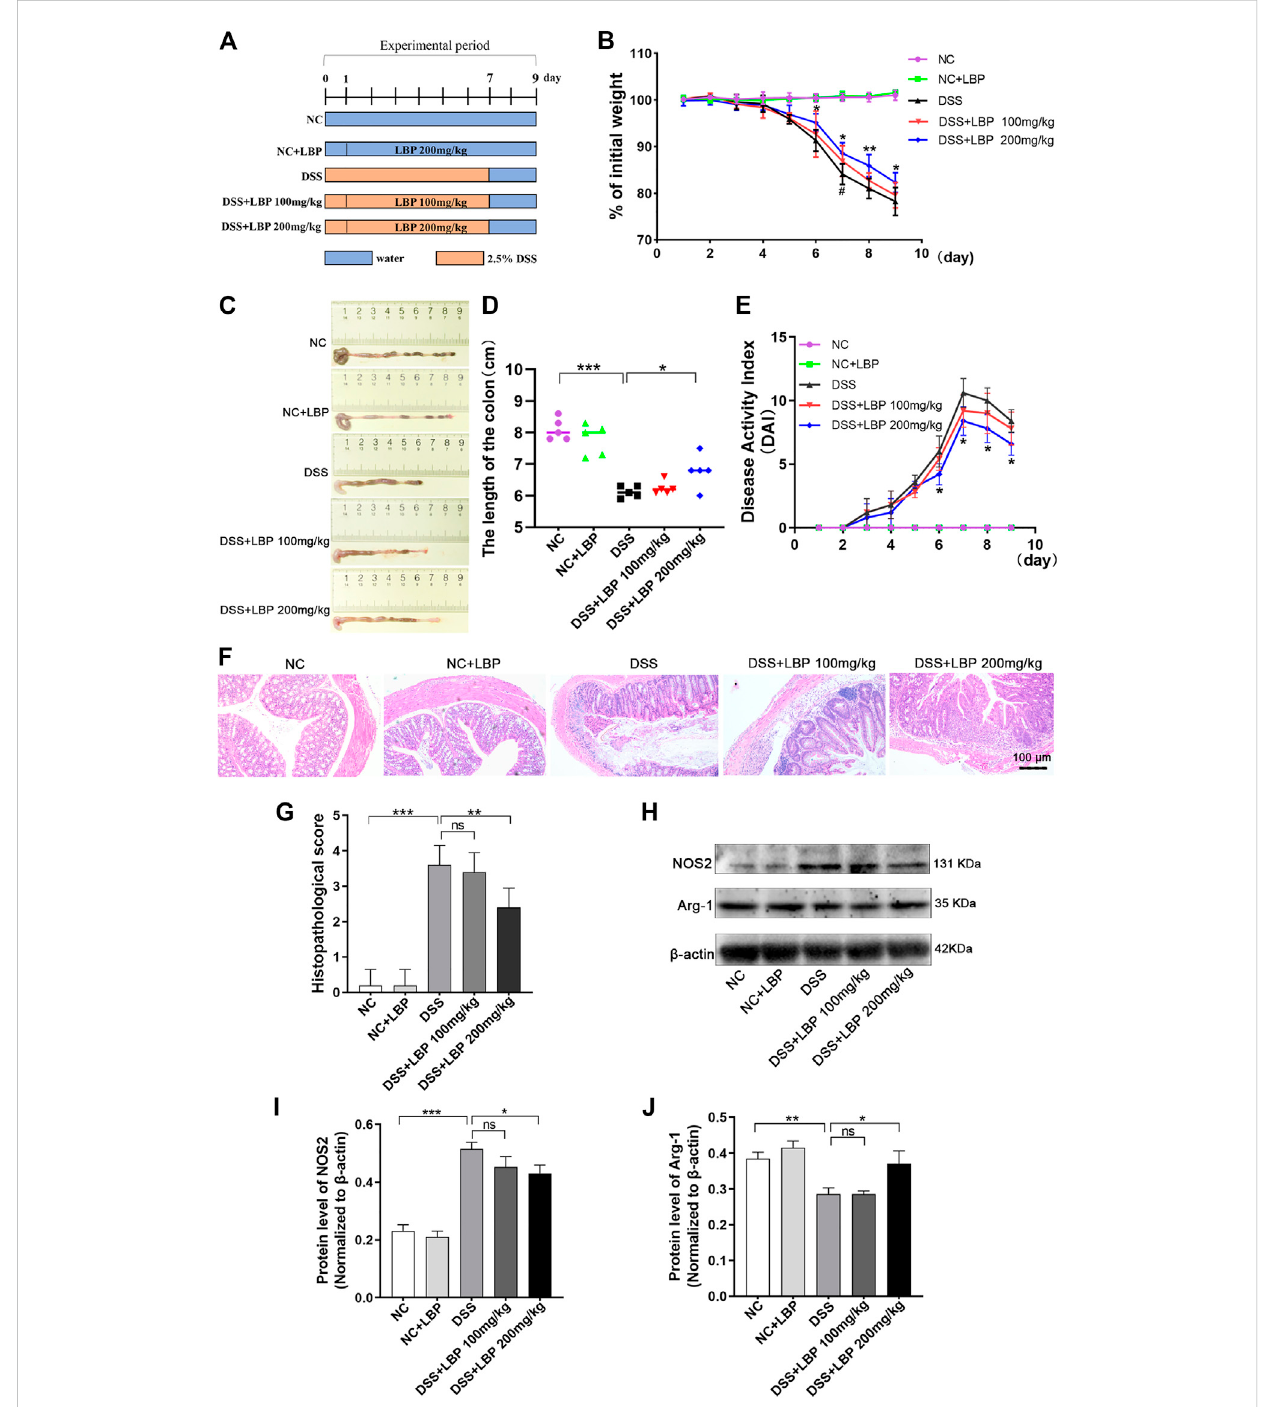
FIGURE 1 LBPobviously attenuatestheseverity ofcolitis inDSS-inducedC57BL/6 mice. (A) Experimental procedure for building colitis modelusing 2.5%DSS. (B) The weight of mice in the fi ve groups was assessed daily. (C) Representative pictures of colon from mice in fi ve groups; the length of the colon was measuredondaynine. (D) Thequanti fi cationanalysisofcolonlengthofmicefrom fi vegroup. (E) TheevaluationofDAIscoreofmicefrom fi vegroups. (F) Representative histopathological images of colon from mice in each group. (G) The statistical analysis of H&E pathological score of colons from eachgroup. (H) WesternblotresultsofNOS2andArg-1intissuesofthecolonfrom fi vegroupsofmice. (I) Thequanti fi cationofNOS2inFigure1H. (J) The quanti fi cation of Arg-1 in Figure 1H. * p < 0.05, ** p < 0.01, *** p < 0.001, the DSS + LBP 200 mg/kg group vs. the DSS group; # p < 0.05, the DSS + LBP 100 mg/kg group vs. the DSS